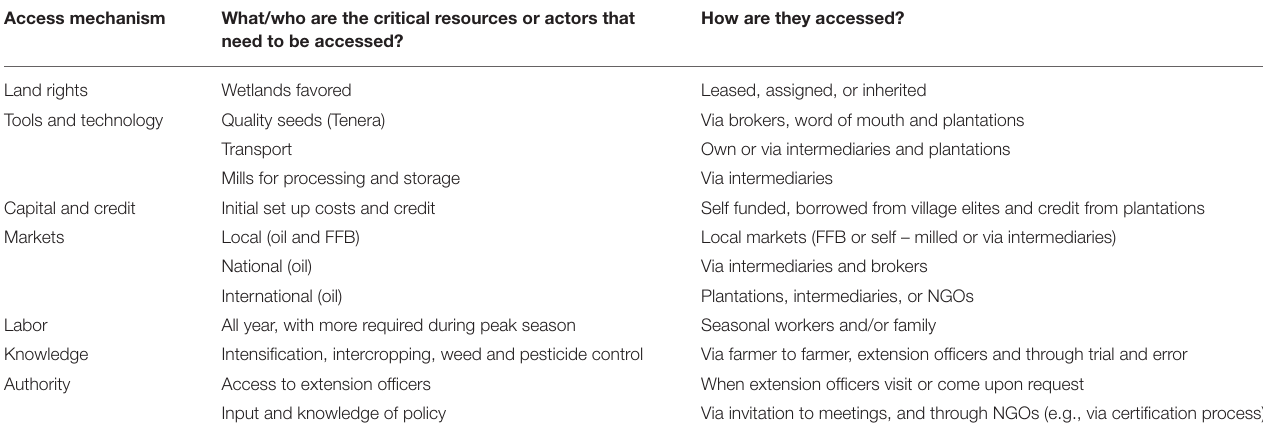
TABLE 3 | Smallholder farmer access by mechanism; summary of findings from the Ghanaian case study. Access